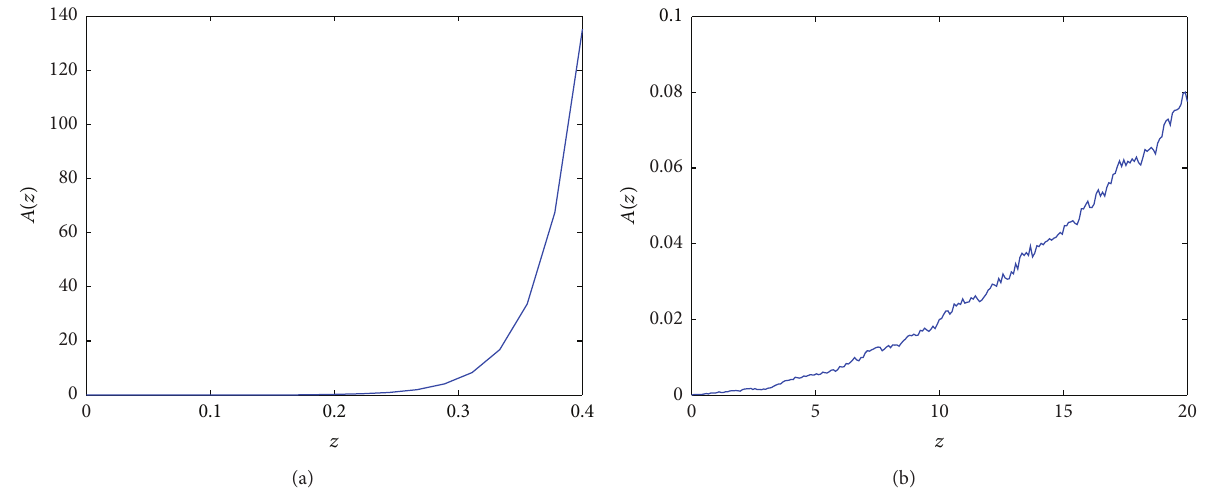
Figure 16: (a) Linear evolution of the lattice soliton with 𝜇 = 1.5 and 𝑉 0 = 0 . (b) Linear evolution of the lattice soliton on the Penrose lattice with 𝜇 = 1.5 and 𝑉 0 = 3.5